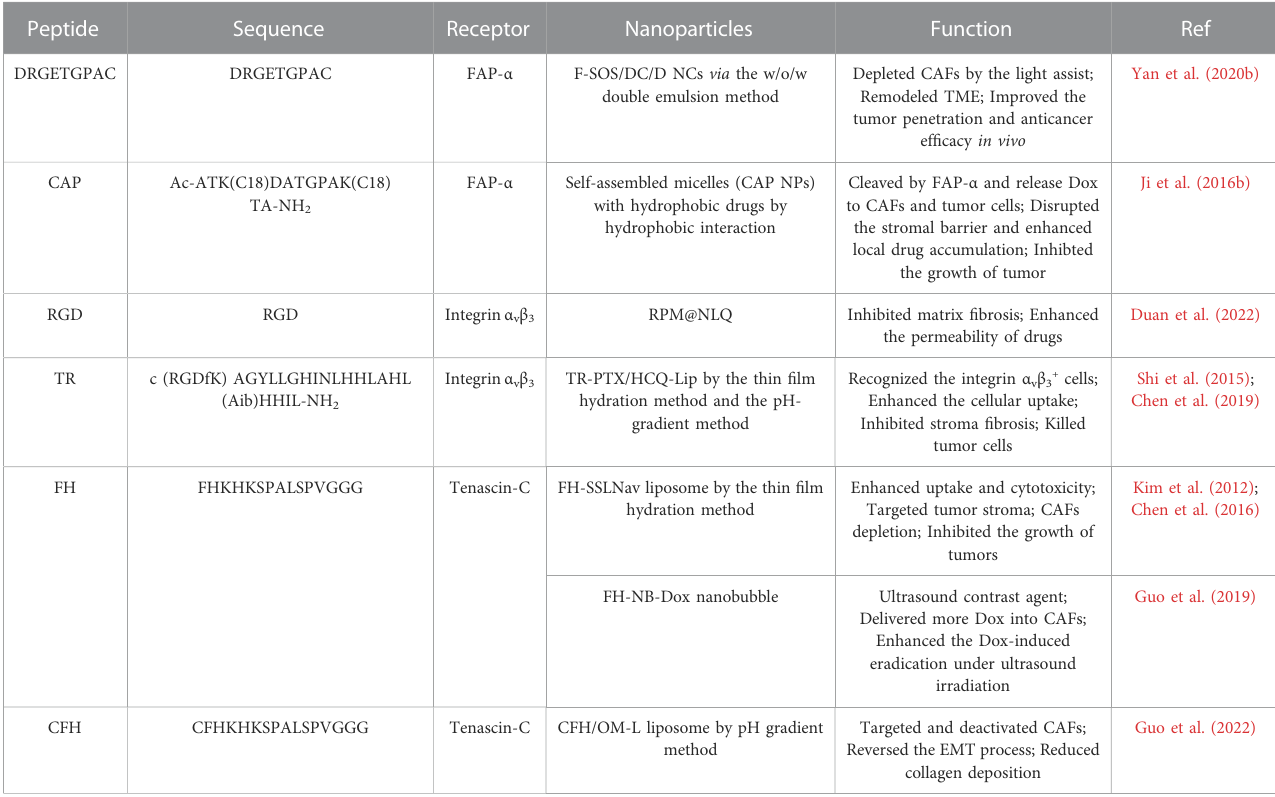
TABLE 2 Peptide-based assembling nanoparticles for